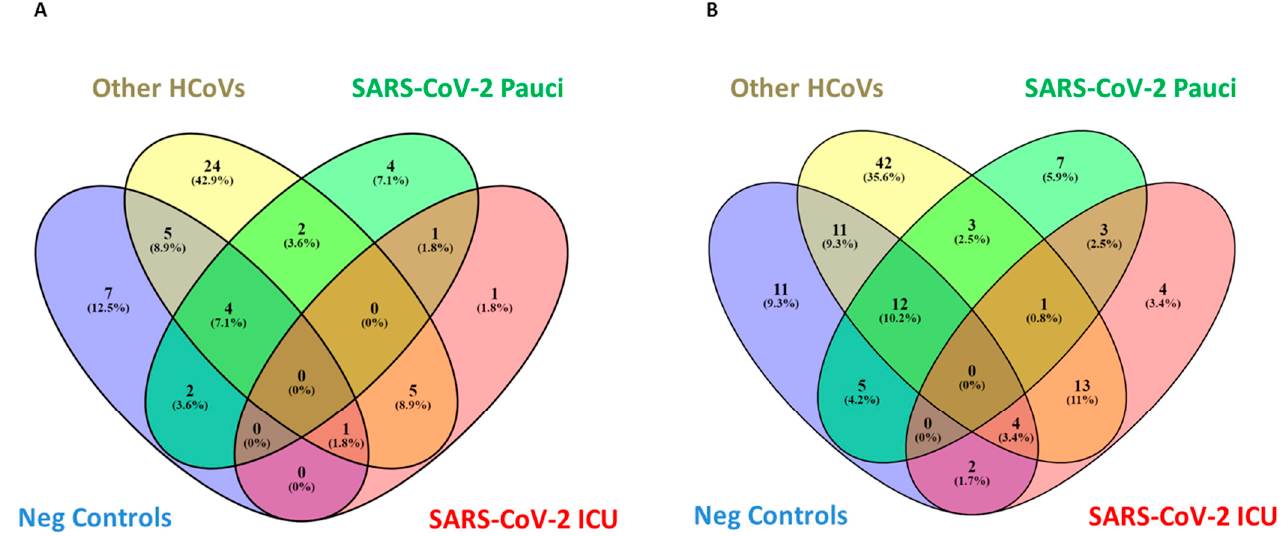
Figure 5. Venn diagrams showing the number of distinct and shared families ( A ) and genera ( B ) up and downregulated between subjects grouped by Neg Controls, other HCoVs, SARS-CoV-2 Pauci and SARS-CoV-2 ICU.